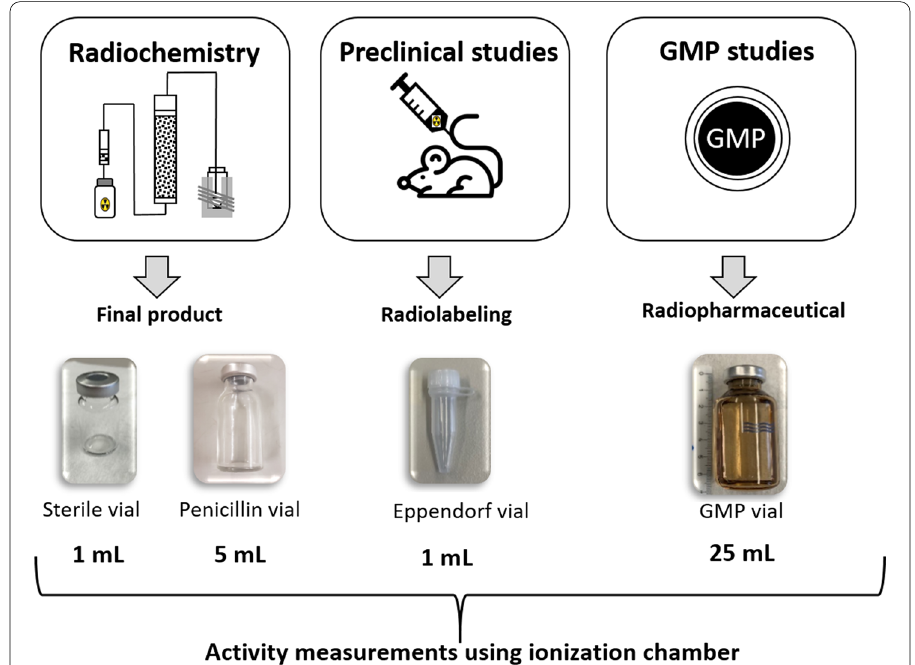
Fig. 3 Scheme of the different container types used to assess the activity at different stages of 161 Tb